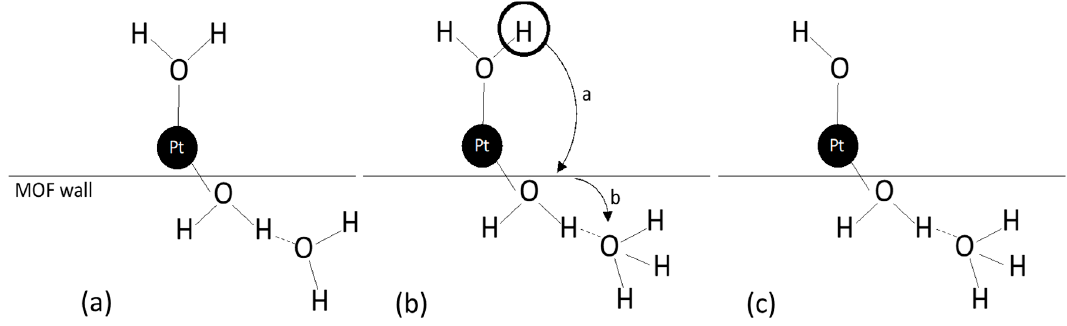
Figure 20. CO activation mechanism on Pt/MOF catalysts: (a) coordinated H 2 O molecule, ( b ) transferring of a proton first to the neighbour H 2 O molecule, ( c ) -OH group on Pt 11+ and a H 3 O + cation on the water